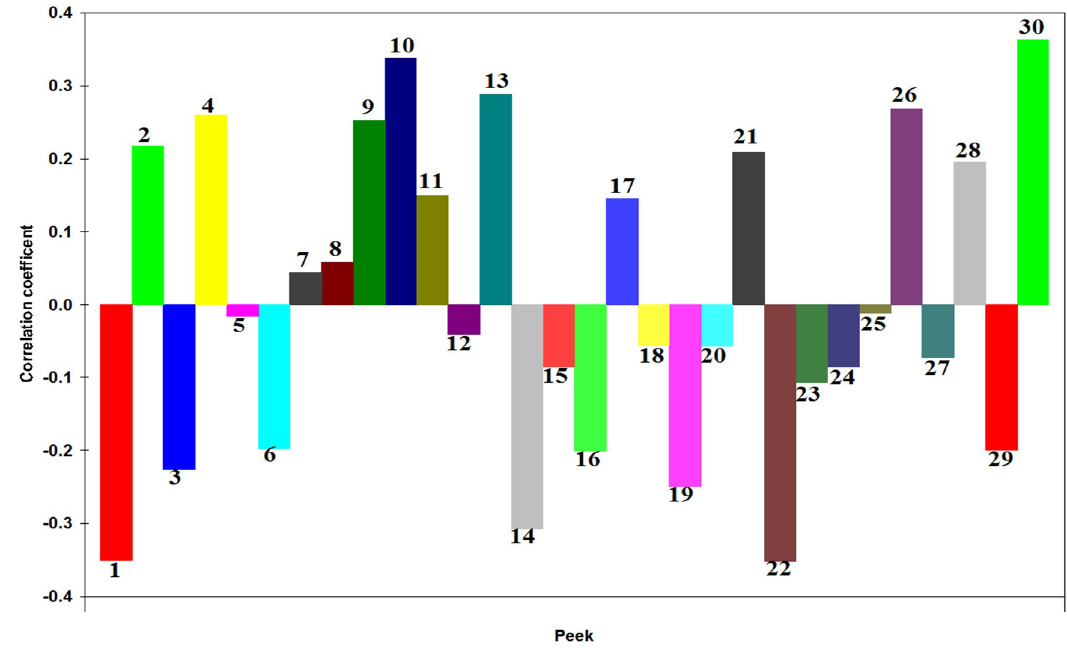
Figure 2. Standardization regression coefficients of partial least squares analysis (PLSR) equations of P. corylifolia .